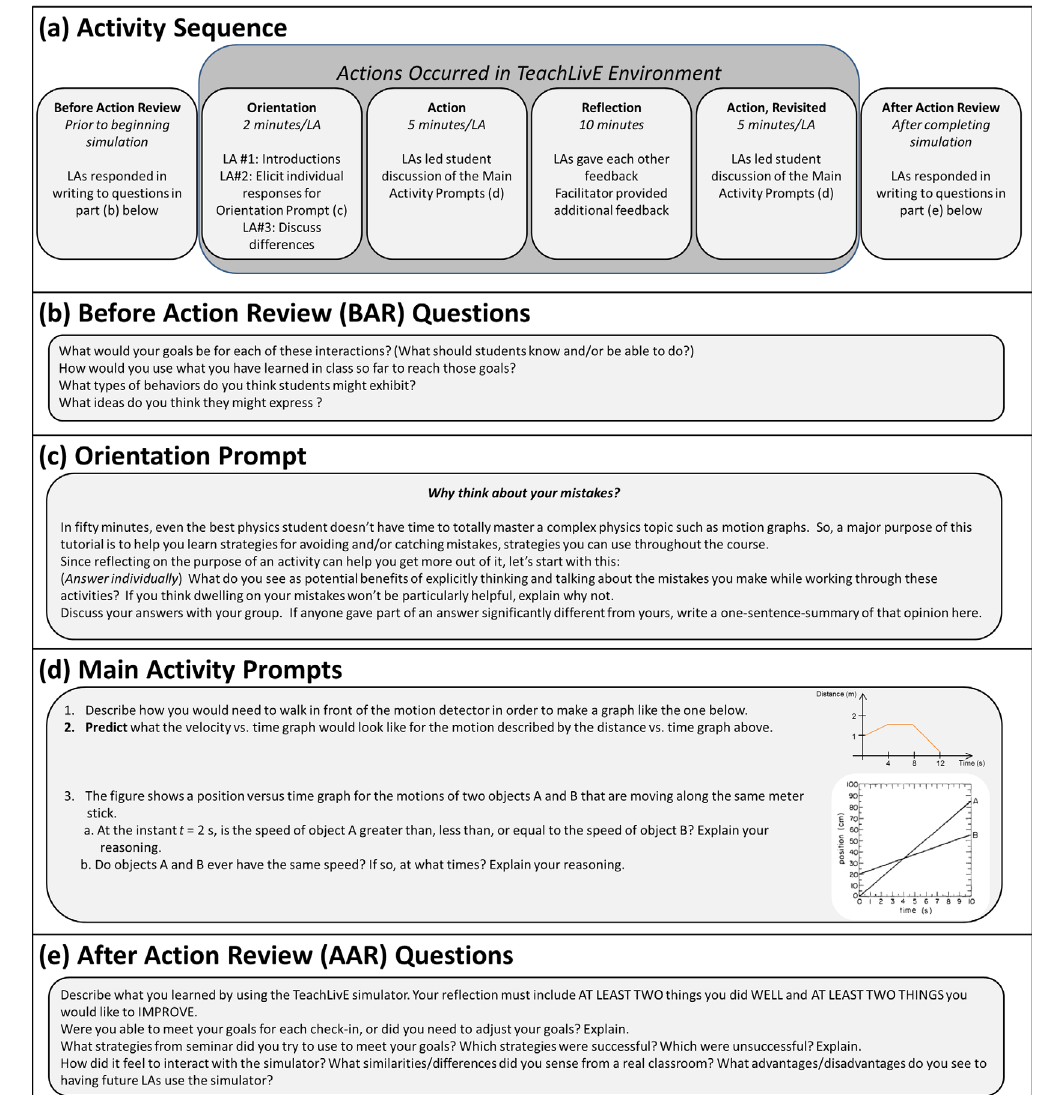
FIG. 2. Time line and details of the physics mixed-reality simulation activity. The LAs ’ experience was based on the Action Review Cycle, and included planning what to practice in the simulation, two rounds of practice separated by group reflection, and a final written